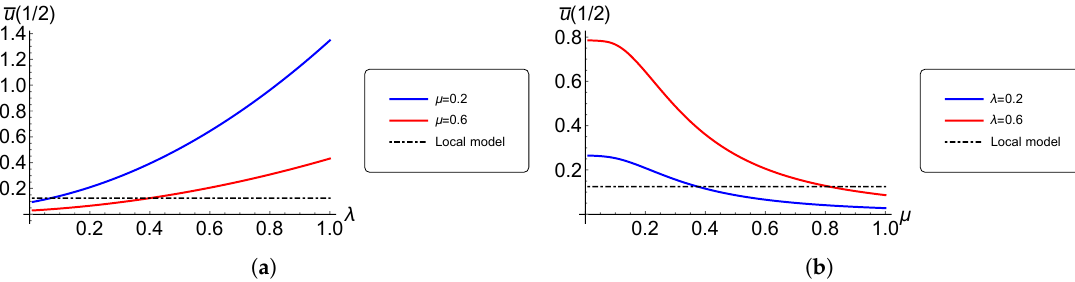
Figure 11. CC nano-rod subject to a uniformly distributed axial load. ( a ) The non-dimensional maximum axial displacement ¯ u ( 1/2 ) for the NSG method vs. the non-dimensional characteristic parameter λ for µ = 0.2 and µ = 0.6. ( b ) The non-dimensional maximum axial displacement ¯ u ( 1/2 ) for the NSG method vs. the non-dimensional characteristic parameters µ for λ = 0.2 and λ =